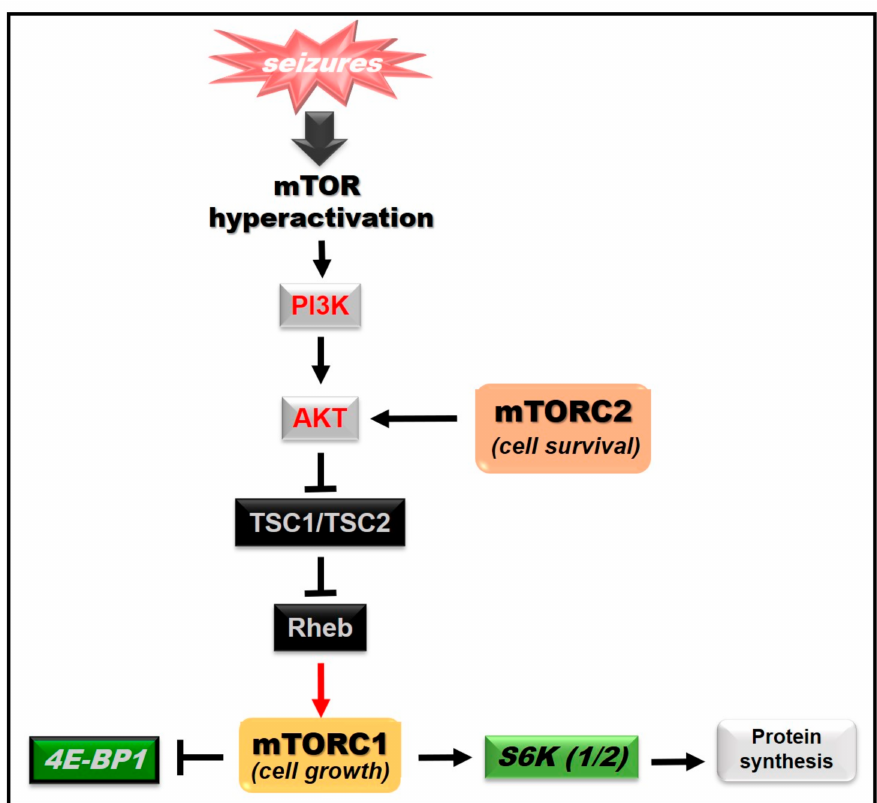
Figure 2. Simplified schematic representation of the hyperactivated mammalian target of rapamycin (mTOR) signaling due to seizures. Once the mTOR pathway is activated, it acts on subsequent e ff ectors to suppress autophagy, as well as promote protein synthesis and cell survival related to the epileptogenesis process. Arrows and bars represent activation and inhibition, respectively. PI3K, phosphatidylinositol 3-kinase; AKT, protein kinase B; TSC1 / TSC2, tumor suppressor complex 1 / 2; Rheb, ras homolog enriched in brain; mTORC1, mTOR complex 1; mTORC2, mTOR complex 2; 4E-BP1, eukaryotic translation initiation factor 4E-binding protein 1; S6K, ribosomal S6